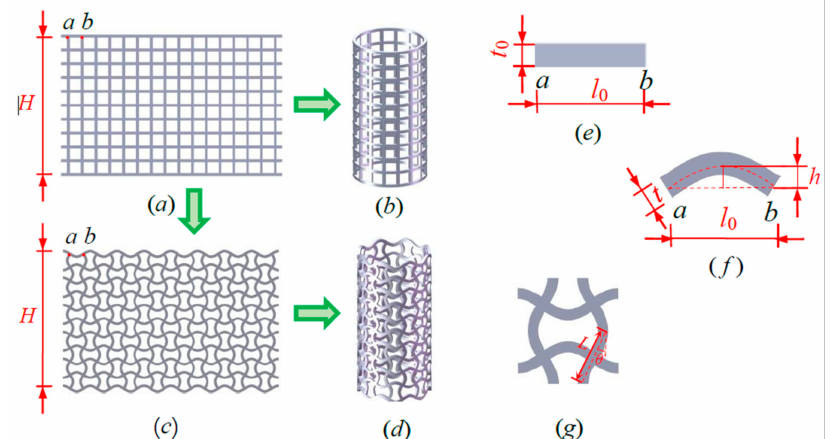
Figure 1. Schematic of ( a ) the square honeycomb lattices, ( b ) the square honeycomb tubes (CSHTs), ( c ) the convex–concave lattices, ( d ) the negative Poisson’s ratio (NPR) convex–concave honeycomb tubes (CCHTs), ( e ) the straight cell walls of ( a ), ( f ) the sinusoidal beams of ( c ), and ( g ) the unit cell of ( d